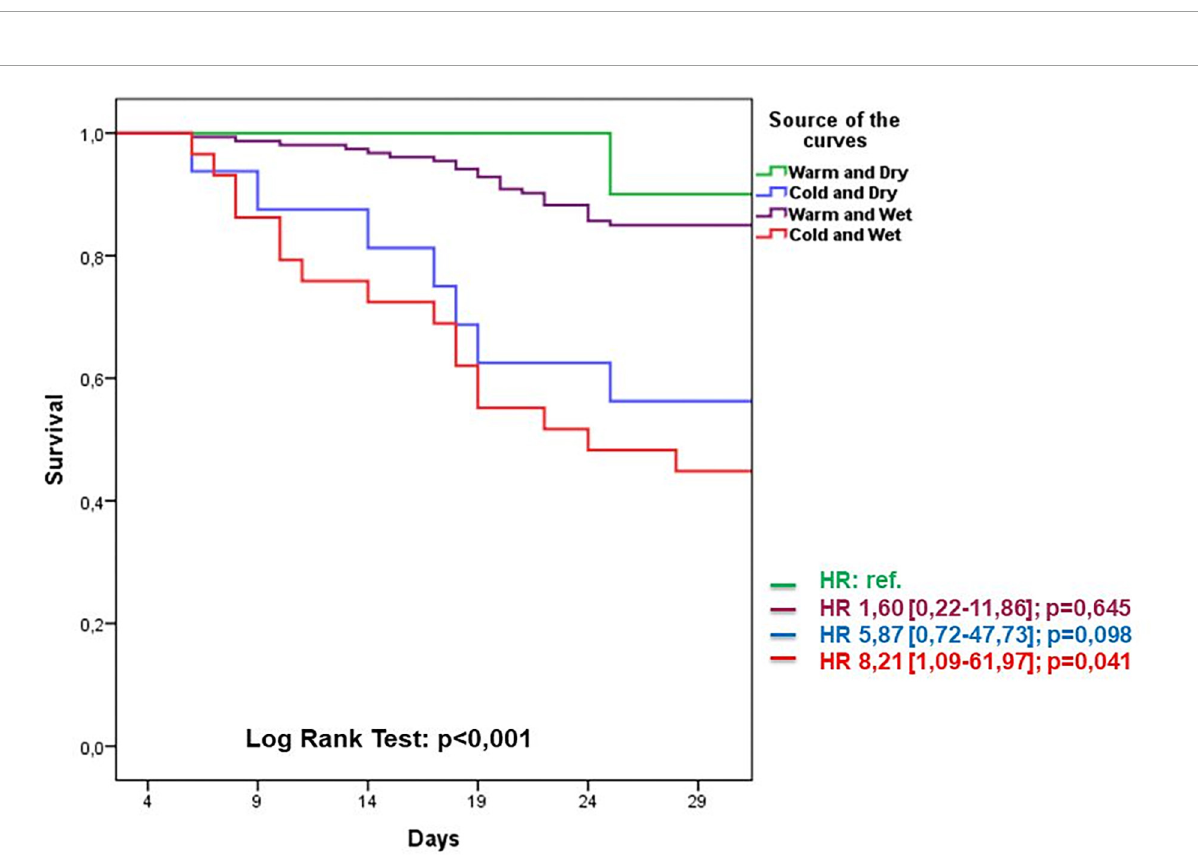
FIGURE5 Kaplan–Meier survival curves related to AHF presentation during 30-day follow-up period groups. Warm and dry (green) cold and dry (blue) warm and wet (violet) cold and wet